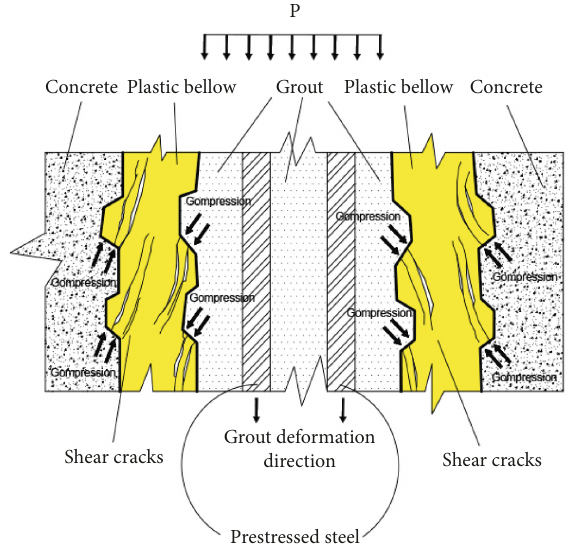
Figure 8: Inside pipe